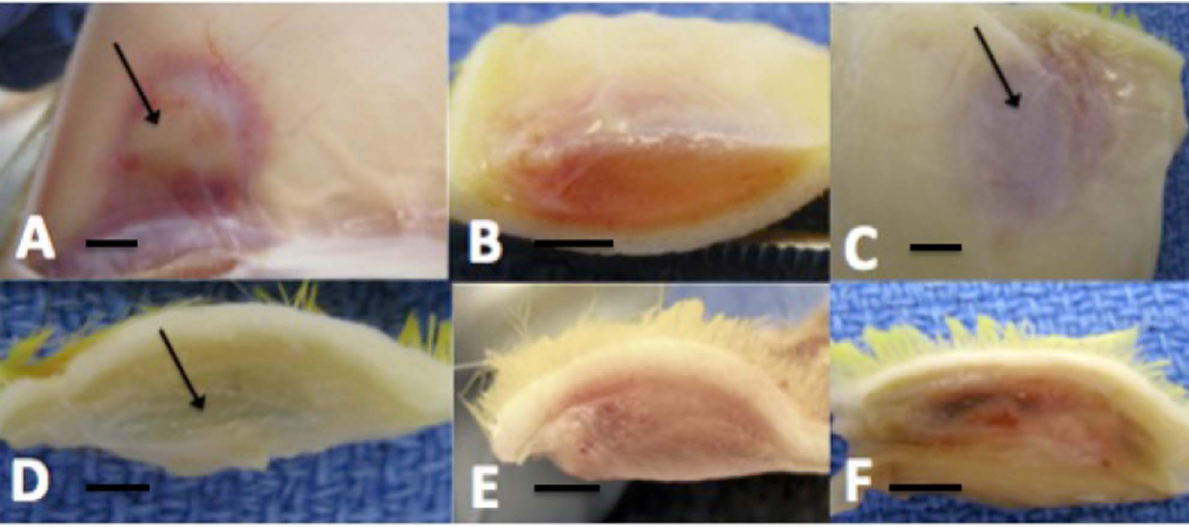
Figure 4. Matrigel plugs in situ. Matrigel was injected into rats with or without 10 ng/mL IL-8, 10 ng/mL IL-6 or 10 ng/mL VEGF-A in a total volume of 0.5 mL. Matrigel was supplemented with supernatants from PBMCs stimulated with filarial ES for 72 h and injected into rats. Matrigel alone and Matrigel containing supernatants from PBMCs cultured in media alone were injected as controls. Matrigel plugs were analyzed at day 9. Representative in situ observations are presented from a single experiment using 6 rats per group. (A) A subcutaneous Matrigel plug (arrow) containing VEGF-A showing a red-colored vascular response in the surrounding tissues and infiltrating the plug. (B) A cross section of a plug containing filarial ES-PBMC products showing discoloration. (C) Distinct outline of the injected plug (arrow) in the sub-cutaneous tissues. (D) A control Matrigel plug free of coloration. (E and F) Matrigel plugs from IL-6-treated (E) and VEGF-A-treated (F) animals showing a significant vascular response with a dark red area. The scale bars represent 1 cm.